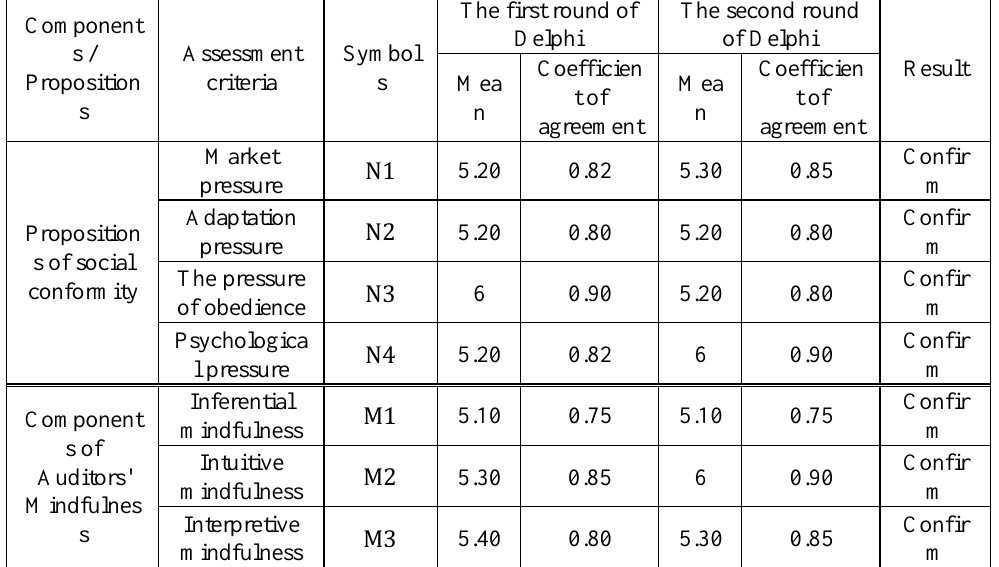
Table 7. The process of the first and second steps of Delphi